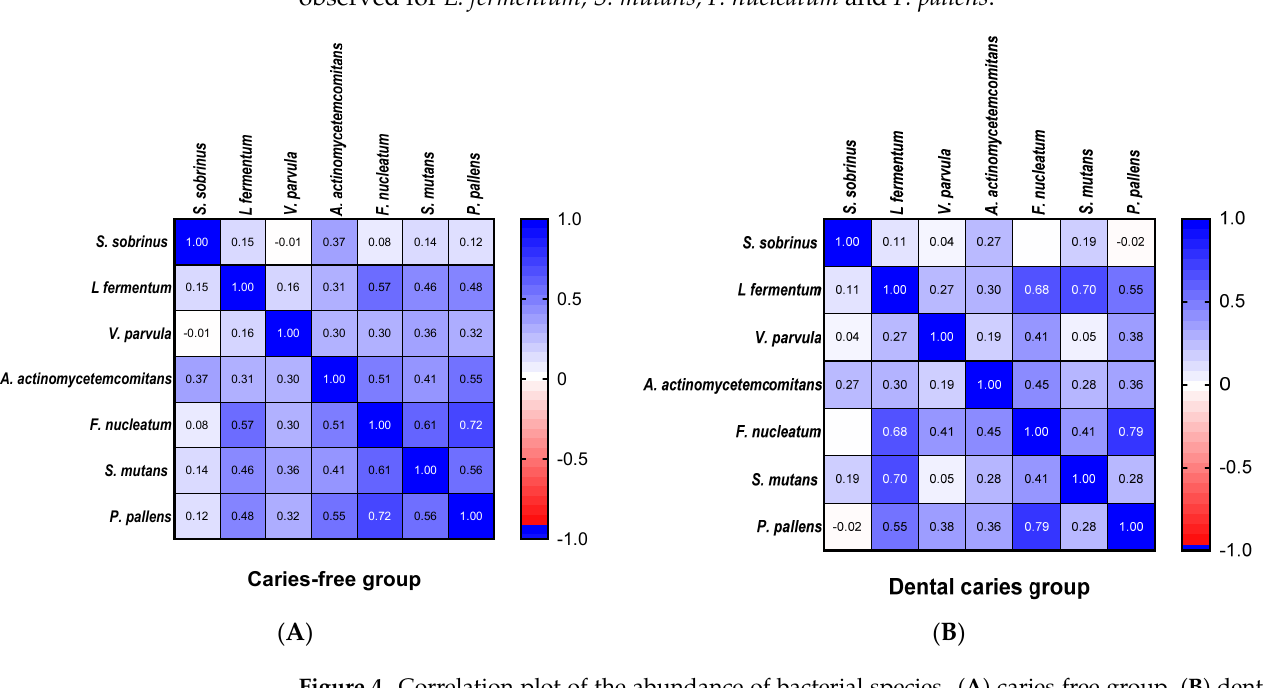
Figure 4. Correlation plot of the abundance of bacterial species. ( A ) caries free group, ( B ) dental caries group. (Spearman rank-order correlations test).